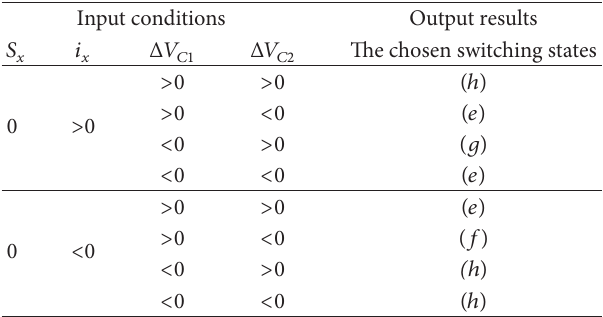
Table 7: Control table for capacitor voltage: 𝑆 𝑥 = 0